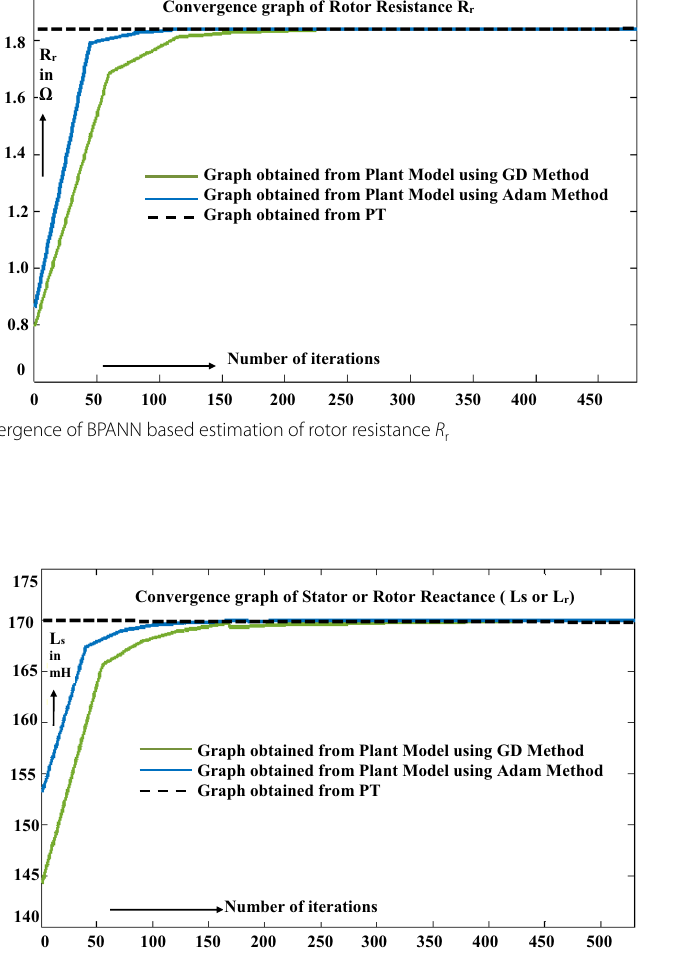
Graph obtained from Plant Model using GD Method Graph obtained from Plant Model using Adam Method